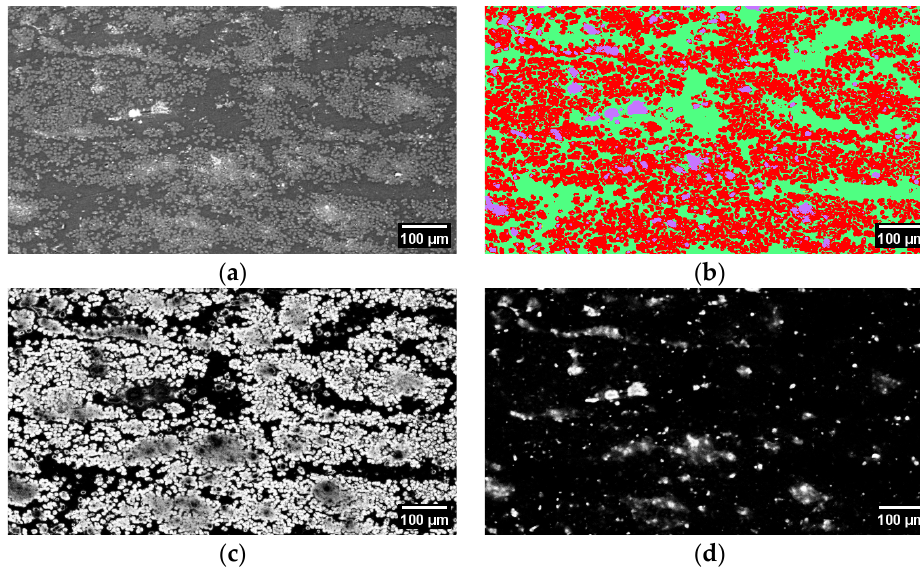
Figure 5. CFRP laminate’s four middle unidirectional layers: ( a ) SEM image, ( b ) WEKA classification, ( c ) the fiber vs. matrix probability map, and ( d ) voids and debris probability map.